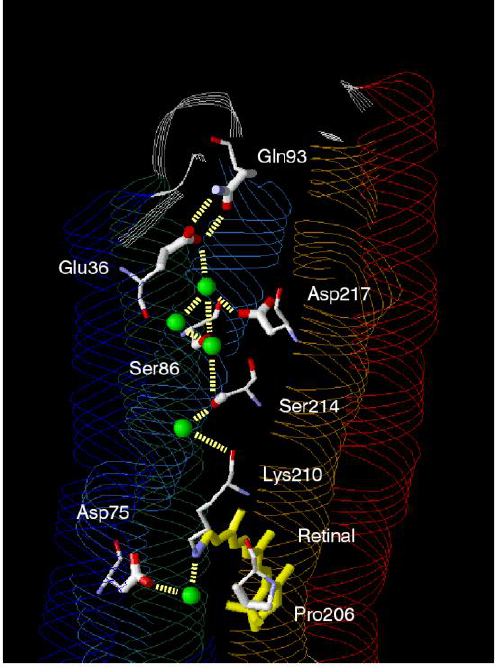
Figure 31. X-ray crystallographic structure of the cytoplasmic region of ASR (PDB entry 1XIO [16]). Top and bottom regions correspond to the cytoplasmic surface and retinal binding pocket, respectively. Green spheres represent water molecules in the cytoplasmic region. Hydrogen-bonds (yellow dashed lines) are inferred from the structure. This figure is reprinted with permission from Kawanabe et al . [77]. Copyright 2008 American Chemical